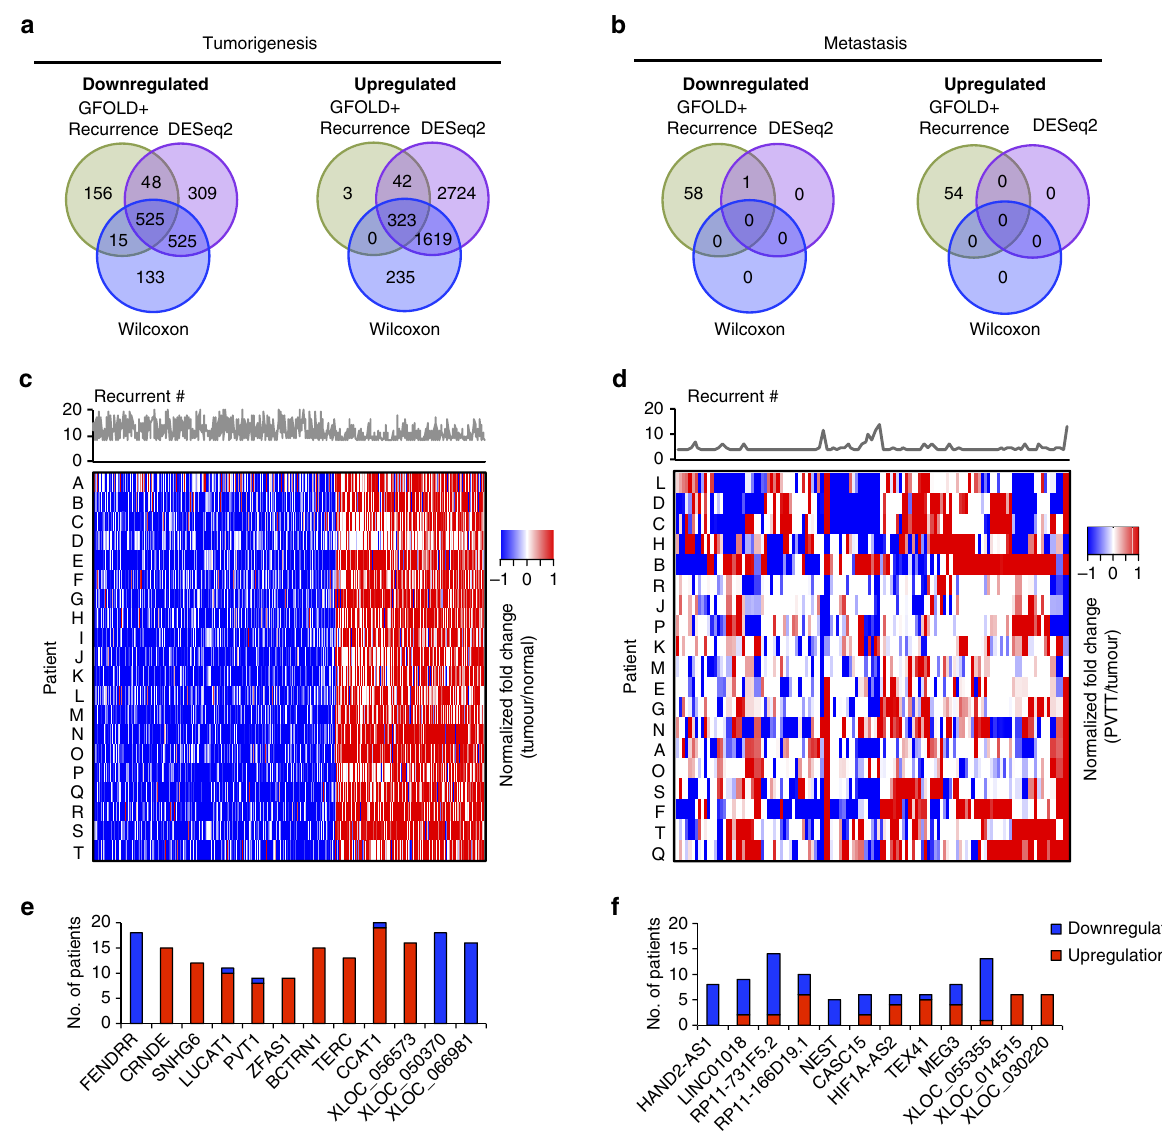
Figure 2 | Recurrently deregulated lncRNAs in primary tumours and PVTTs. Identification of recurrently deregulated lncRNAs: recurrently downregulated and upregulated lncRNAs that were predicted by three statistical methods to be associated with ( a ) tumorigenesis and ( b ) metastasis. Fold-change of expression in each individual patient for ( c ) recurrently deregulated tumorigenesis-associated lncRNAs; ( d ) recurrently deregulated metastasis-associated lncRNAs (tumour versus PVTT). Patient I was not included in the analyses related to metastasis because the PVTTsample of patient I was contaminated. Stacked bar charts showing examples of recurrently deregulated lncRNAs, including tumorigenesis-associated ( e ) and metastasis- associated ( f ) lncRNAs. The number on the y axis is the number of patients with differential expression of each